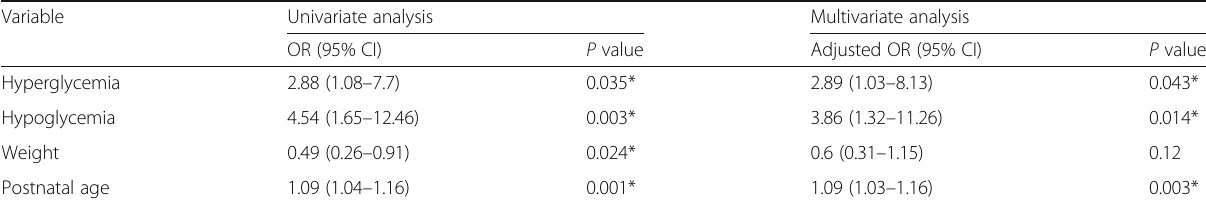
Table 3 Univariate and multivariate logistic regression analysis for prediction of mortality by the glycemic status